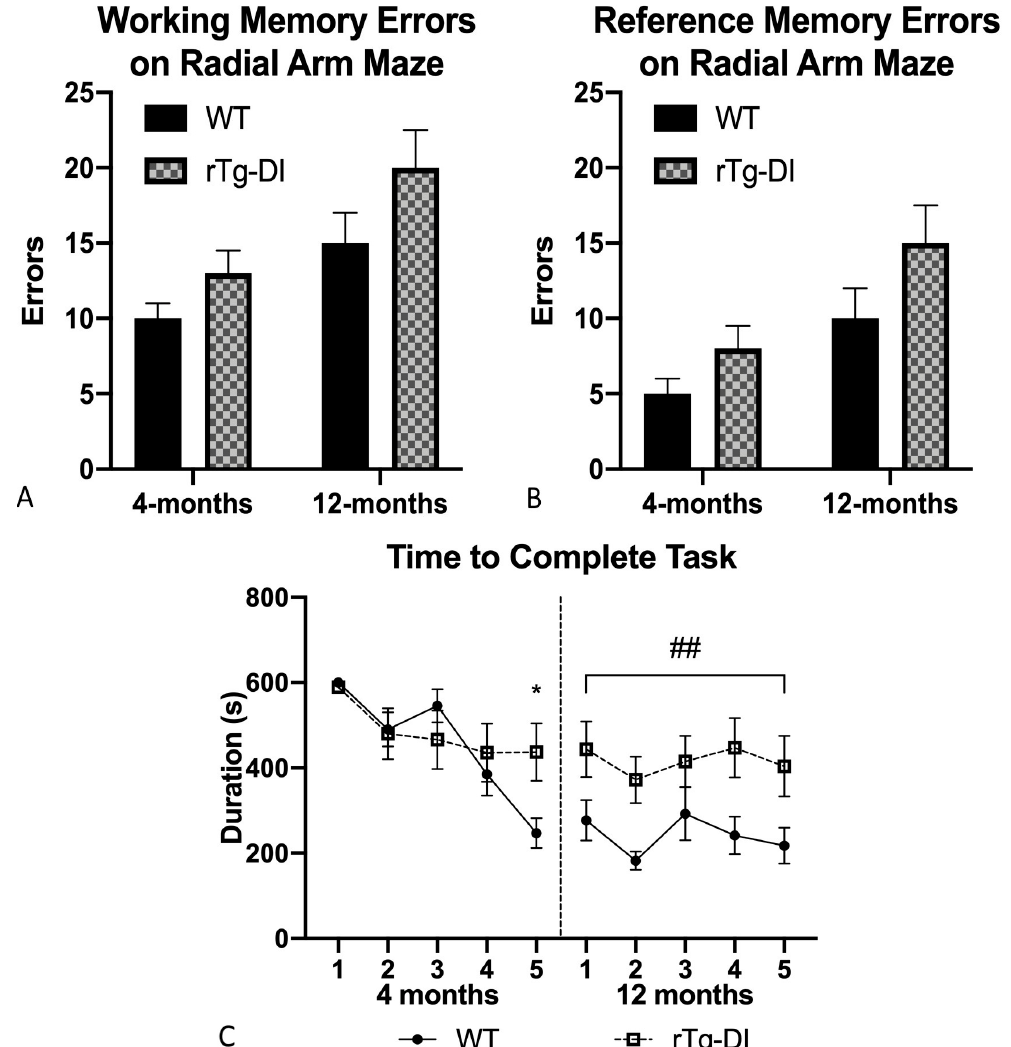
Figure 9. Radial arm maze. ( A ) Average working (WME) and ( B ) reference memory errors (RME) across 5 trial days were only marginally elevated in the rTg-DI rats though rTg-DI took longer to complete trials at 12 months than WT rats ( C ) ## p < 0.005, * p < 0.01. Data represent mean + SEM.